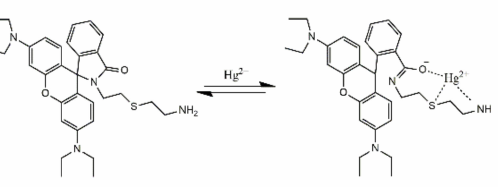
Figure 2. The proposed sensing mechanism of RMTE (Table 1, No. 2) for Hg 2+ [34].